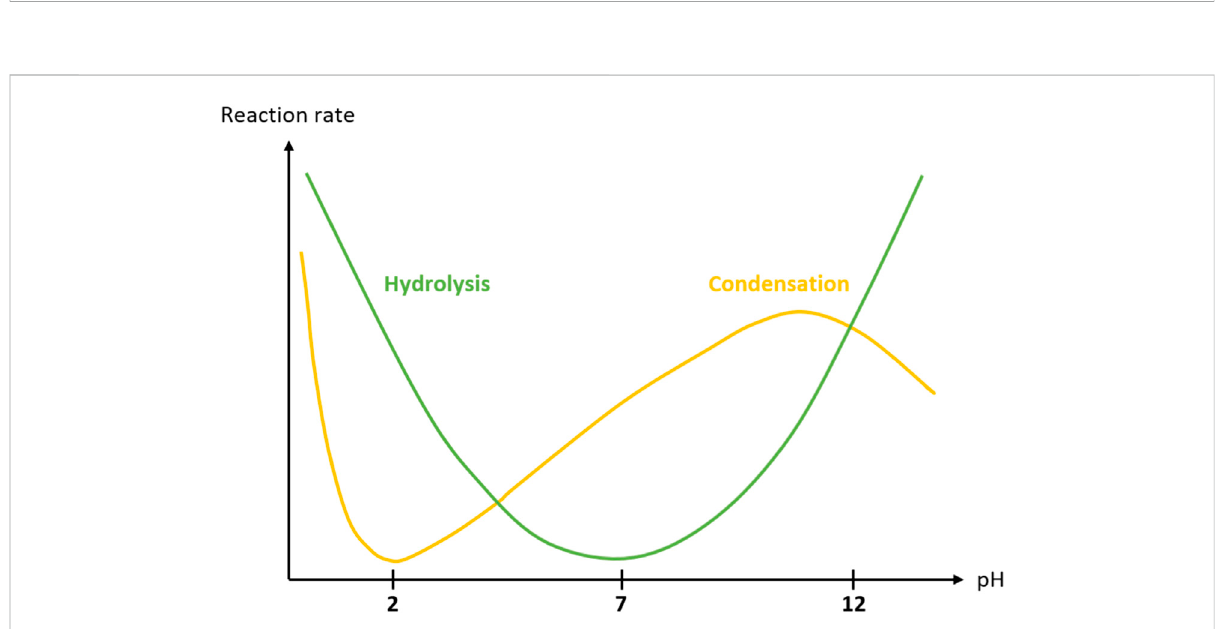
FIGURE 2 Reaction rate of tetraethylorthosilicate (TEOS) hydrolysis (green curve) and condensation (yellow curve) as a function of pH. (Brinker and Scherer, 1990). Similarly, hydrolysis and/or condensation of trialkoxysilyl groups can be catalyzed by acids, bases but also